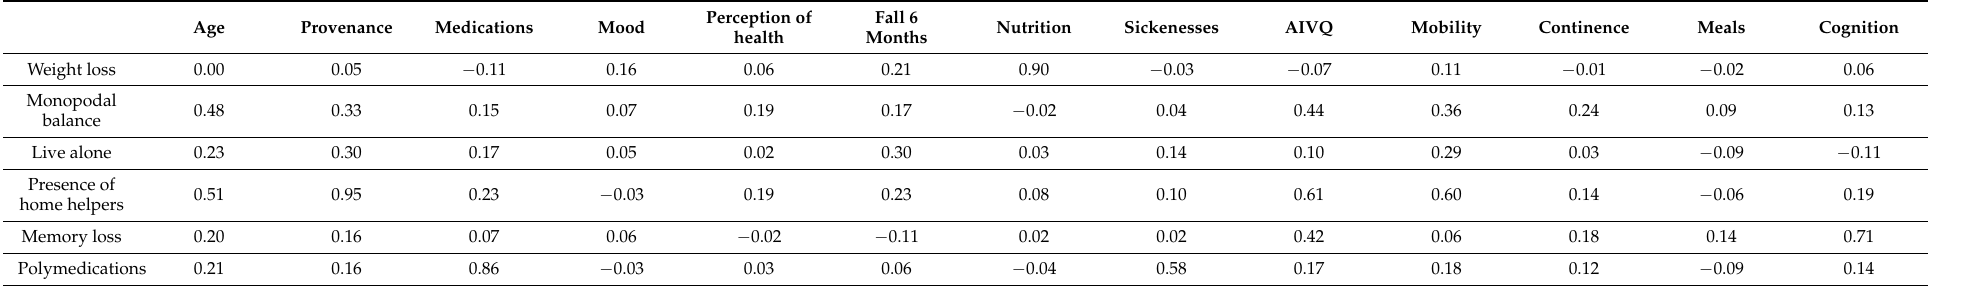
Table 6. Pearson correlation matrix between Zulfiqar and SEGA elements and scores (see heatmap below).